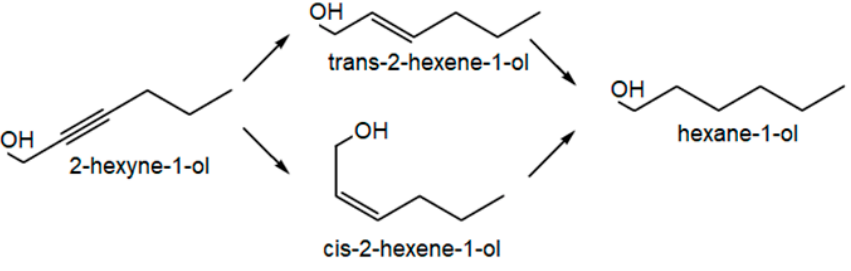
Table 3. Results of the hydrogenation of 3,7,11-trimethyldodecyn-1-ol-3 in ethanol on Pd catalysts. С